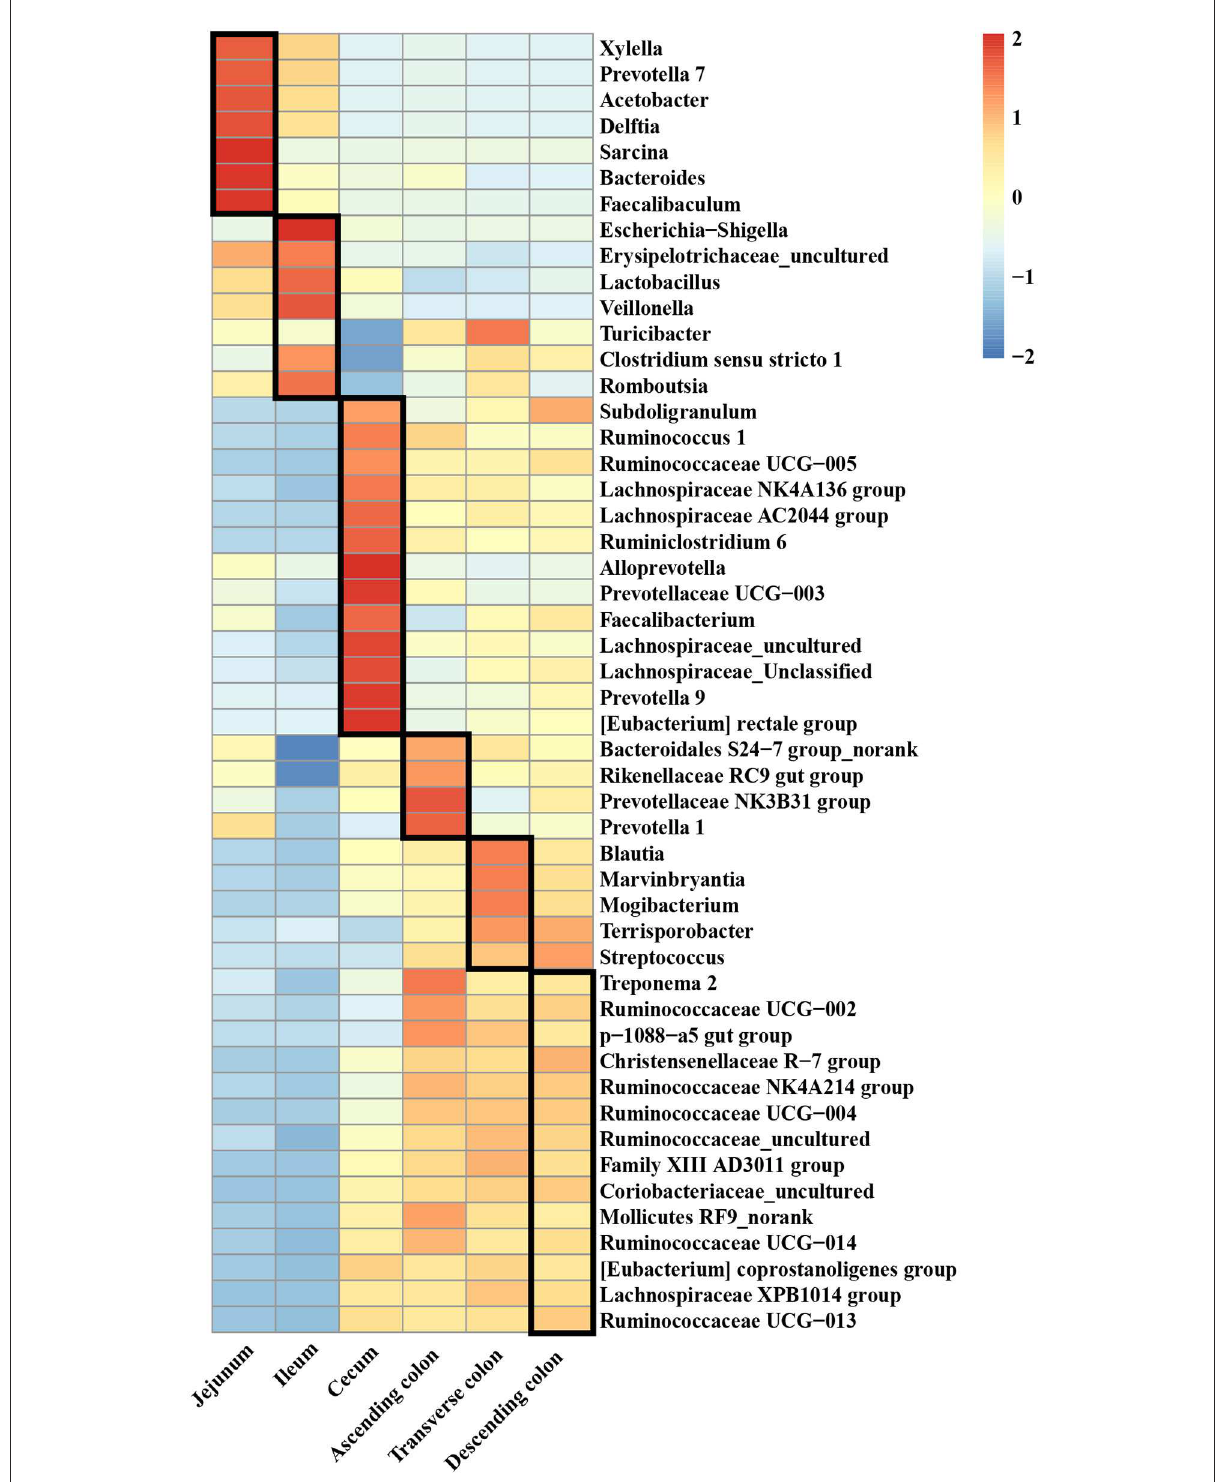
FIGURE3 The top 50 genera in different intestinal locations of